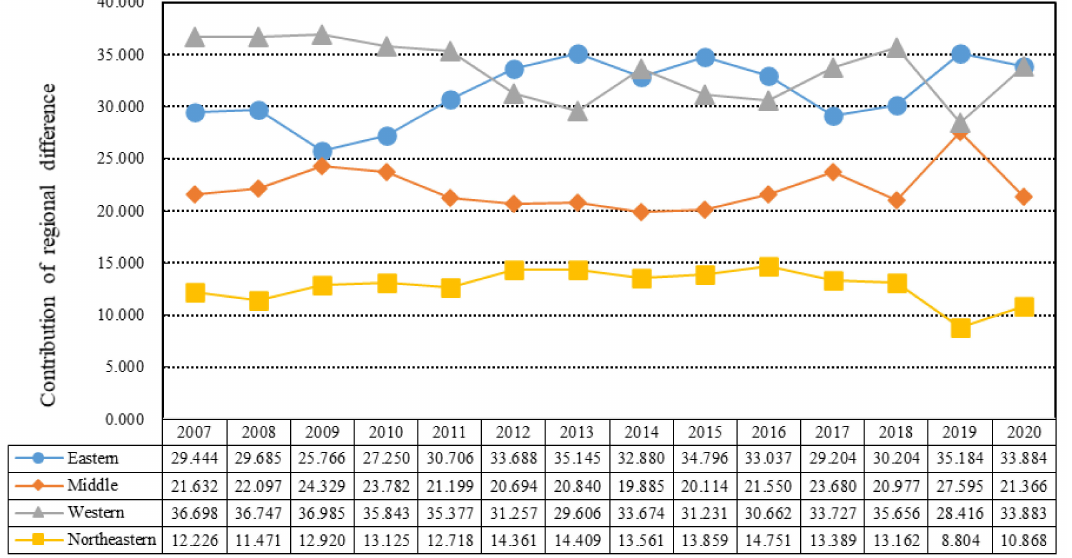
Figure 7. Theil index contribution rate of cities’ EWP in different regions from 2007 to 2020.